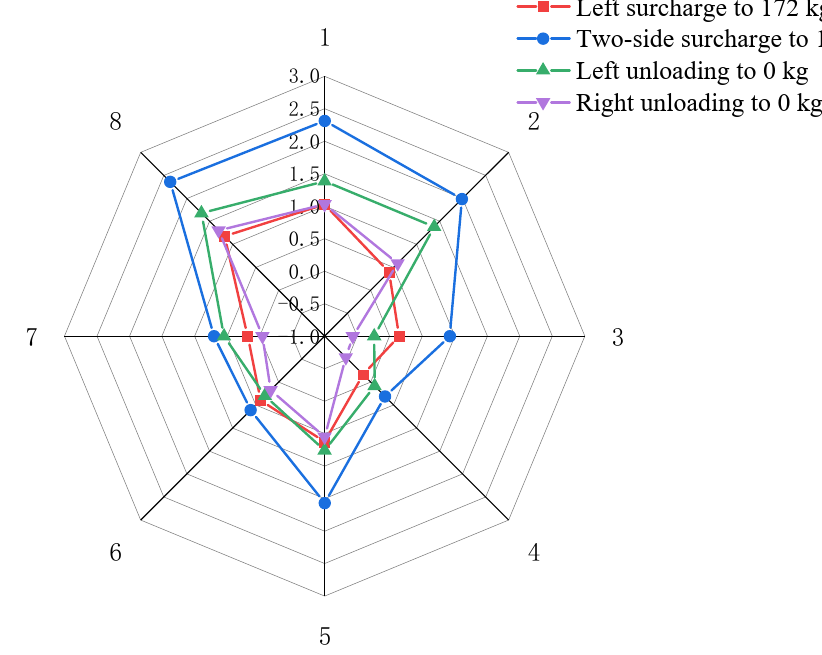
Figure 14. Variation in additional surrounding pressure under different surcharges for Case 2 (unit: kPa).